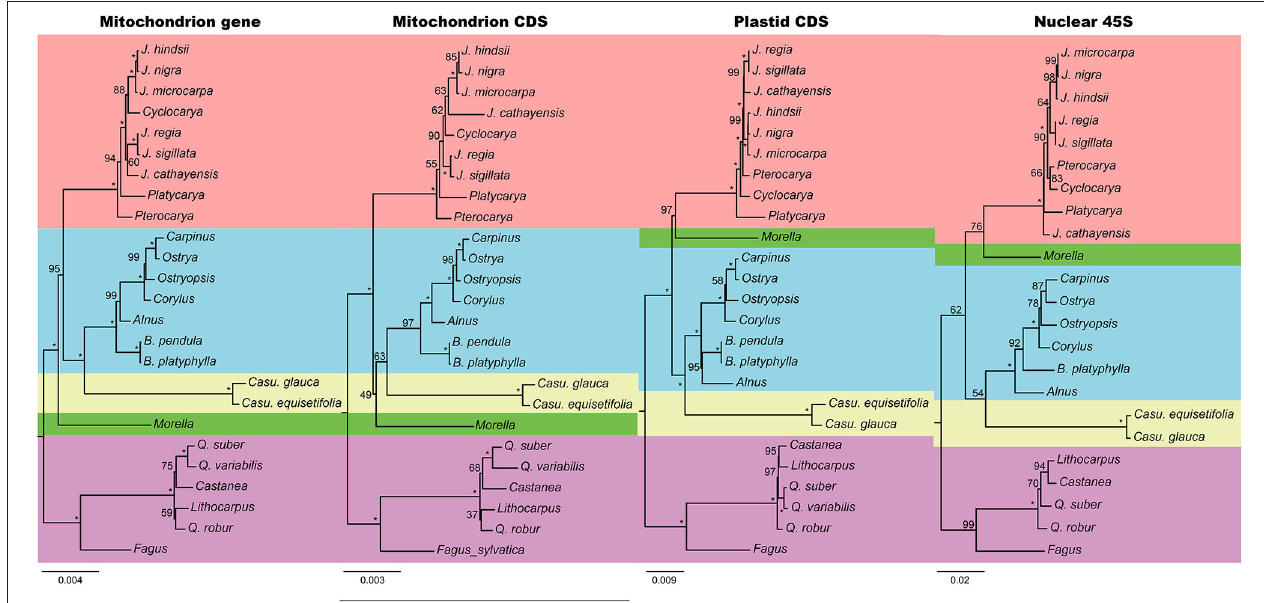
FIGURE 3 | Phylogenetic trees reconstructed by mitochondrial genes, mitochondrial CDSs, plastid CDSs, and nuclear 45S. Numbers at nodes indicate the bootstrap support, and the full supports (100) were marked by asterisks. Each family used a different color as the